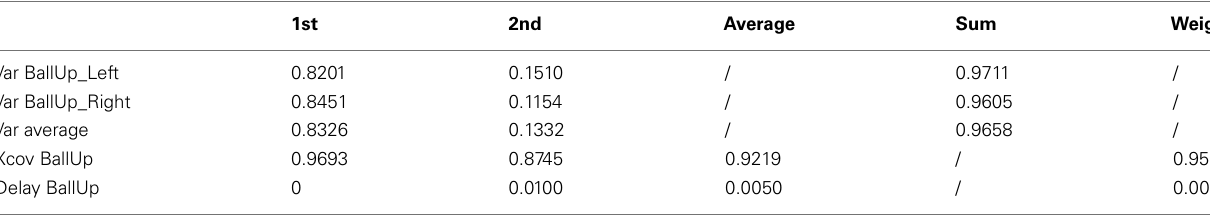
TableA6 | Reaching a target with the left and the right hand (2